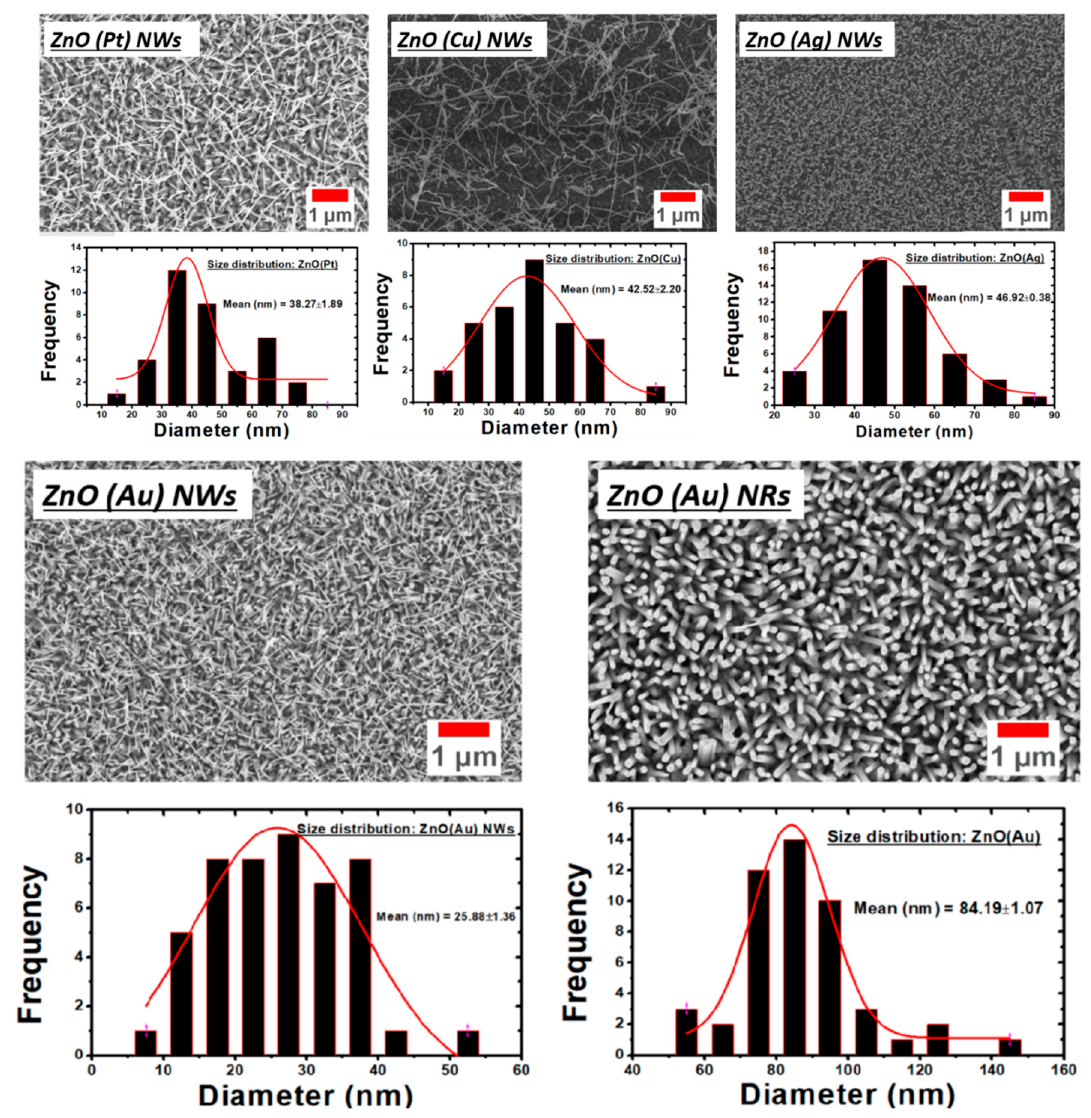
Figure 2. 1D ZnO nanostructures using Au, Pt, Ag and Cu catalysts and its size distribution .